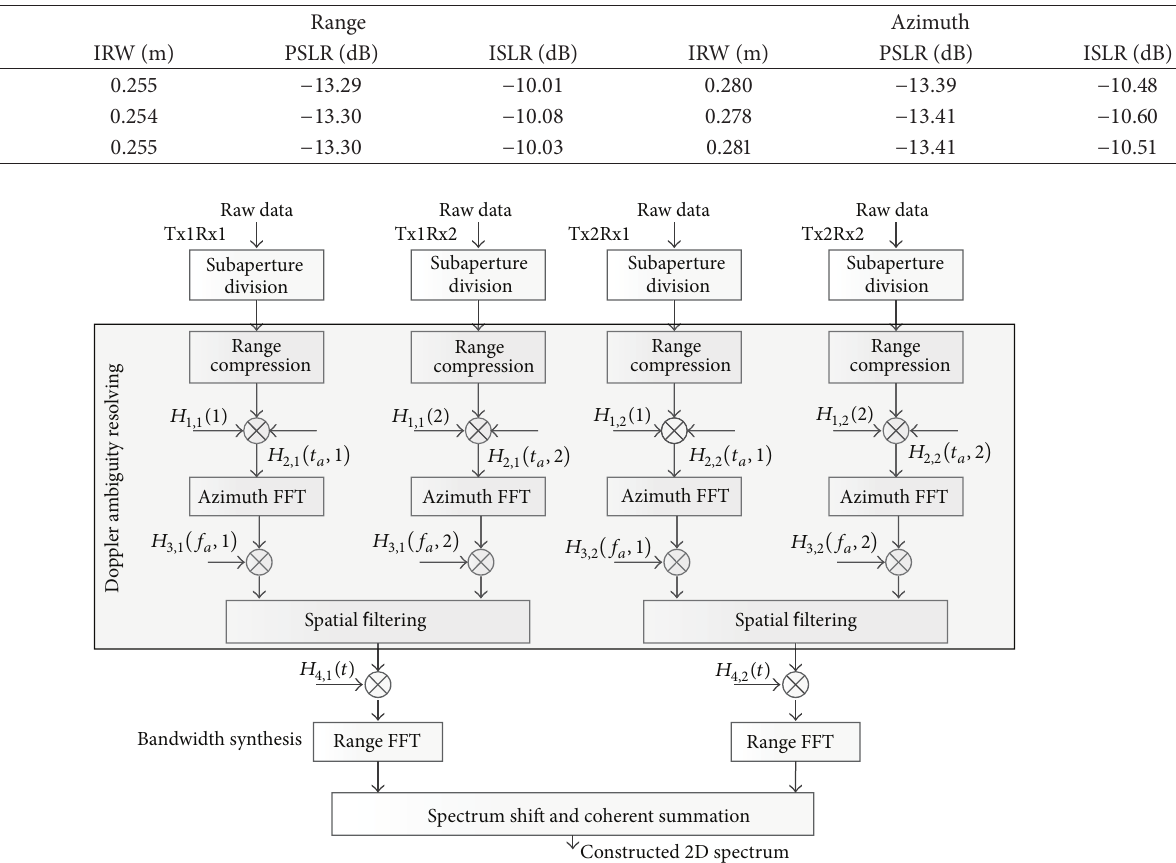
Table 2: Image quality of point targets.